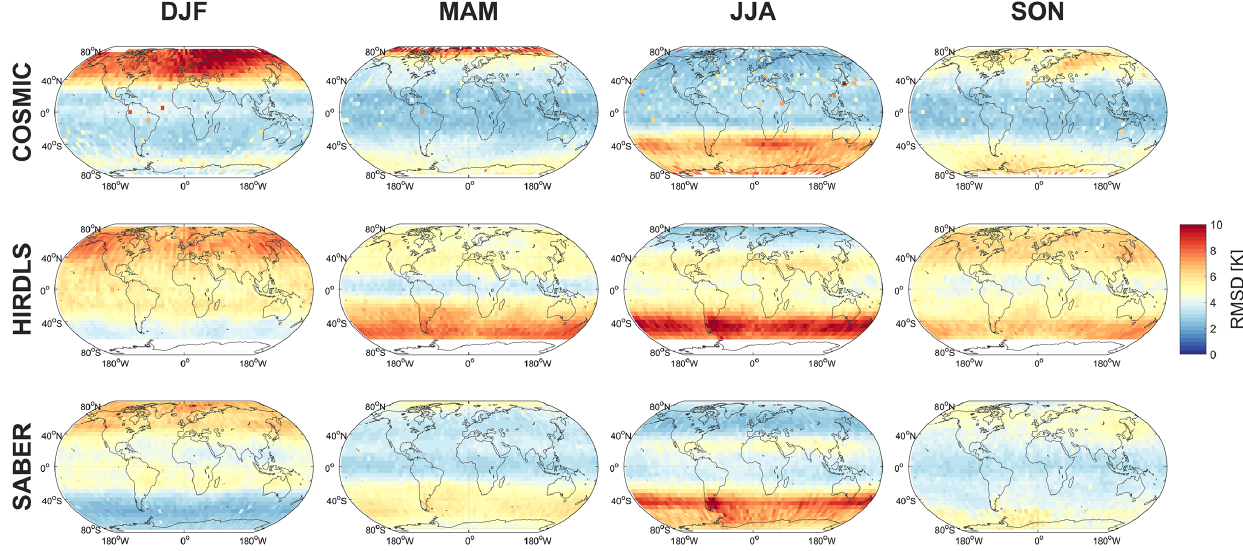
Figure 14. Maps at the 50km altitude level of the RMSD between MRM sampled temperatures and each instrument.